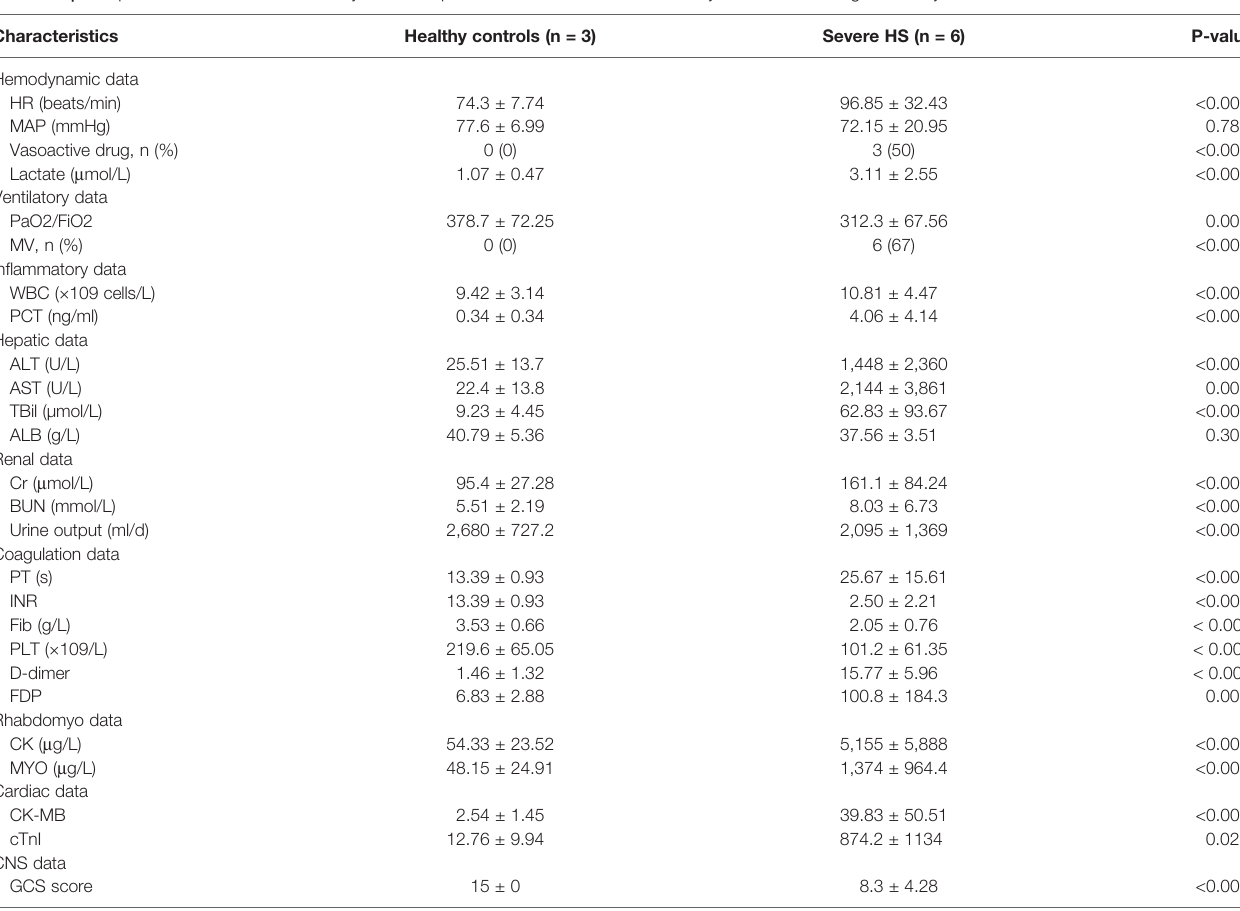
TABLE 2 | Comparison of clinical and laboratory indices of patients with heat stroke and healthy controls according to the day of admission and outcome status.